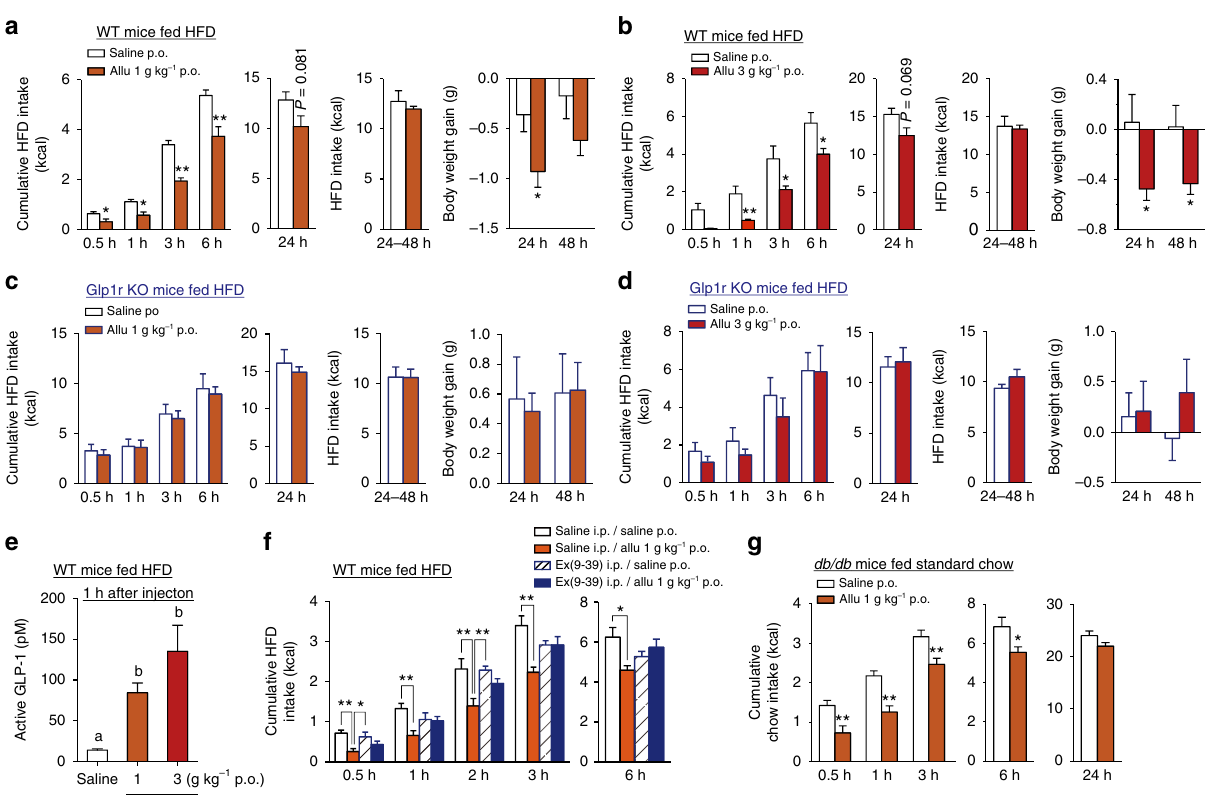
Fig. 4 p.o. D -Allulose suppresses food intake in HFD-fed obese and diabetic db/db mice. a – d Cumulative HFD intake at 0.5, 1, 3, 6, and 24 h and for 24 – 48 h and body weight gain after p.o. administration of Allu (1 and 3 g kg − 1 ) at 19:30 in HFD-fed obese C57BL/6J (wild-type, WT) fasted for 3 h ( a , b ) and HFD- fed Glp1r KO mice fasted for 3 h ( c , d ). n = 5 – 6. e Active GLP-1 level in portal vein 1 h after p.o. Allu in HFD-fed C57BL/6J mice fasted overnight. n = 5 – 6. f Treatment with 600 nmol kg − 1 Ex(9-39) attenuated the effect of p.o. Allu to reduce HFD intake in HFD-fed obese mice. n = 6. g Cumulative standard chow intake after p.o. Allu injected at 10:00 in db/db mice fasted overnight. n = 9 – 10. In a , b , g , * p < 0.05 and ** p < 0.01 by unpaired t -test in each time. In e , different letters indicate p < 0.05 and * p < 0.05, ** p < 0.01 by one-way ANOVA followed by Tukey ’ s test. Error bars are